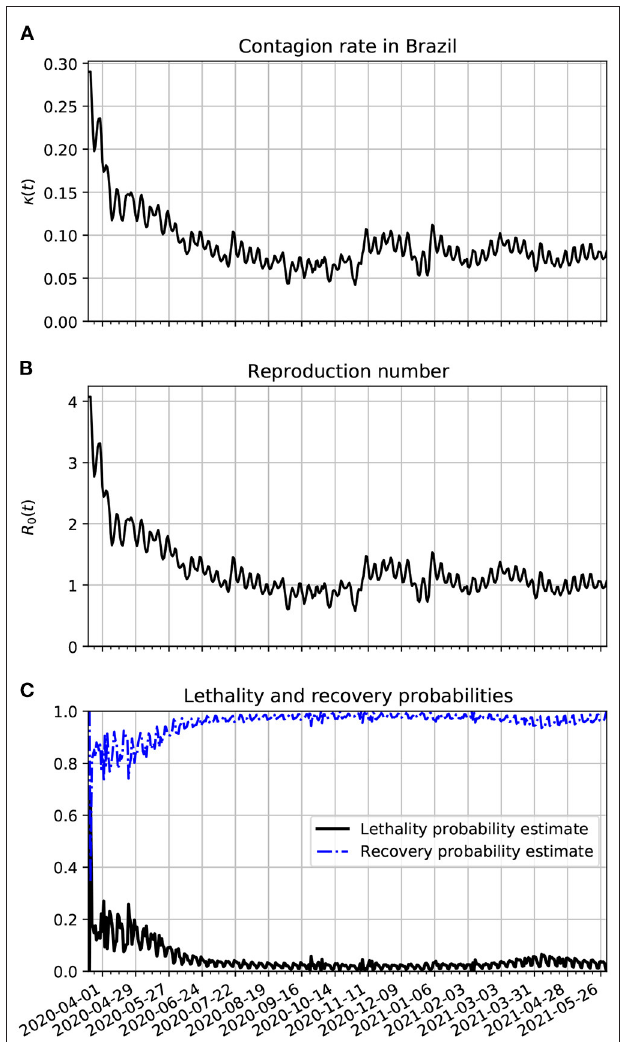
FIGURE 5 | Estimation of the parameters of the epidemiological model applied to Brazil. (A) Time variation of the contagion rate in Brazil. This function was obtained from the statistically estimated active cases as described in Section 3.4.2. The oscillations reflect weekly variations that can be seen in the number of daily new cases. To better fit the data with the predictions of our model we had to truncate κ ( t ) with values above 0.29 at the beginning of the series. (B) Corresponding reproduction number evolution. (C) The lethality and recovery rates obtained with the method described in Section